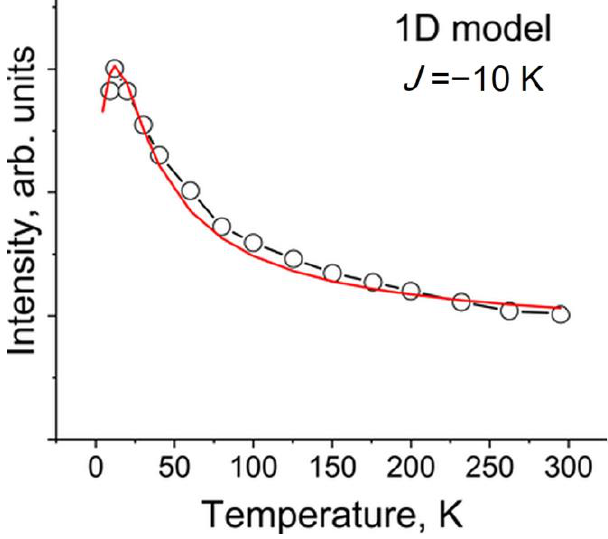
Figure 8. Temperature dependence of integral intensity of the two components of the EPR signal from BEDT-TTF +· (open circles) of salt 1 and fitting of these data by the Heisenberg model for 1D chains of uniformly antiferromagnetically interacting spins (red curve) [24,25].